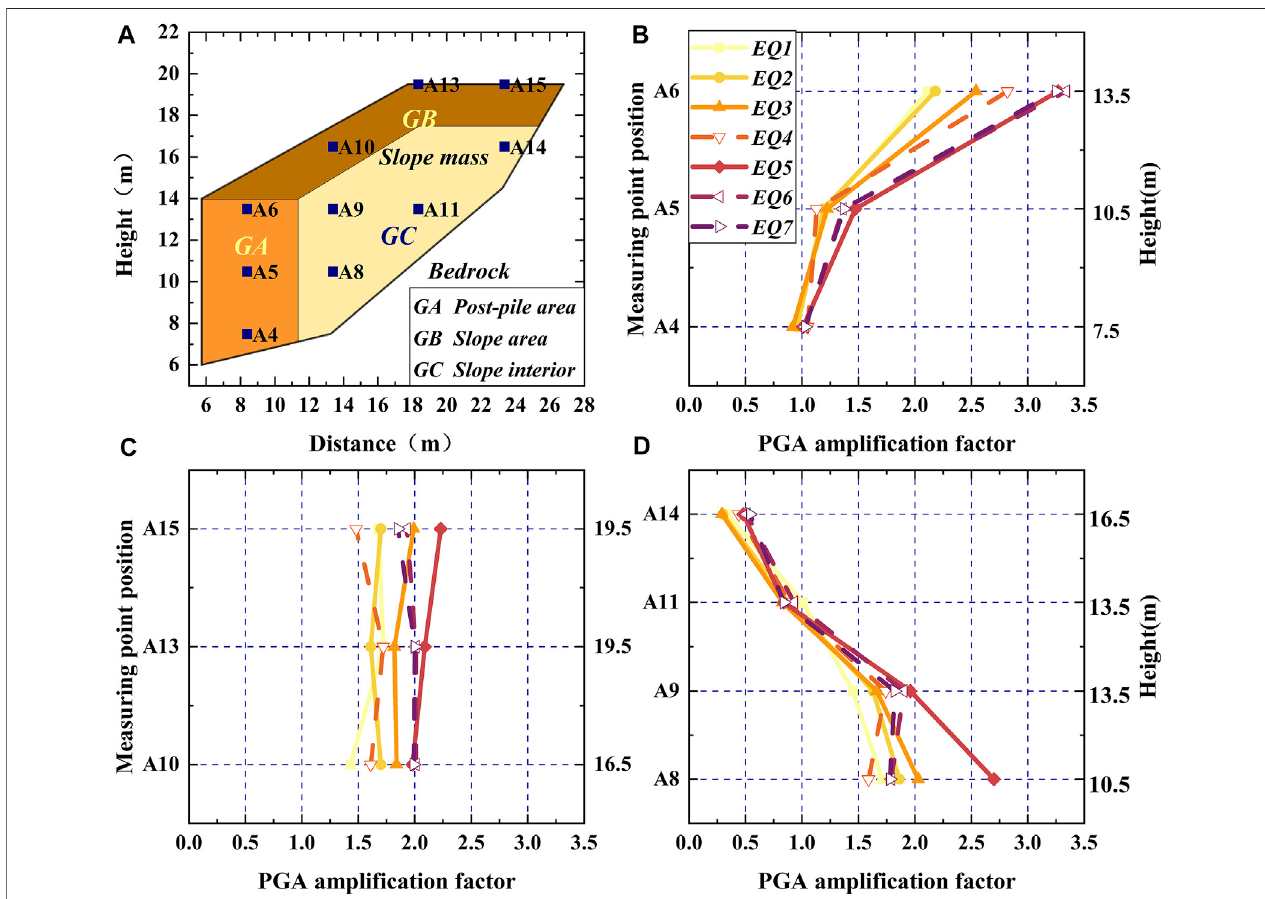
FIGURE 4 | PGA ampli fi cation factor results: (A) Grouping of acceleration measuring points; (B) the results of GA; (C) the results of GB; and (D) the results of GC.